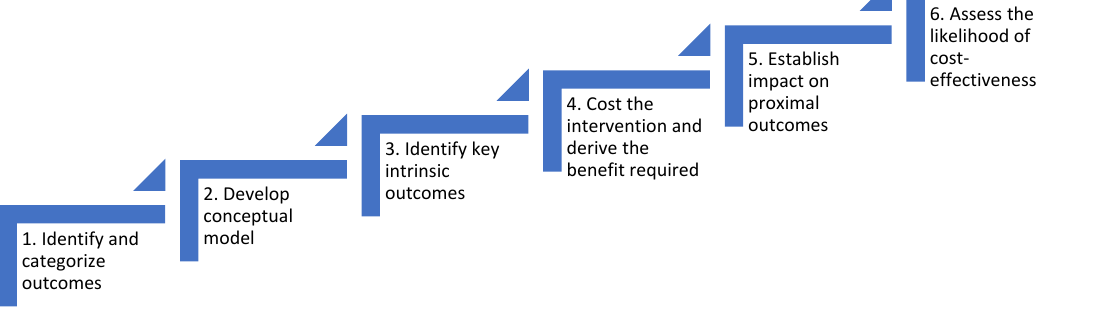
Figure 1. Depiction of the Structured Economic Evaluation Process for Complex Health System Interventions (SEEP-CI).